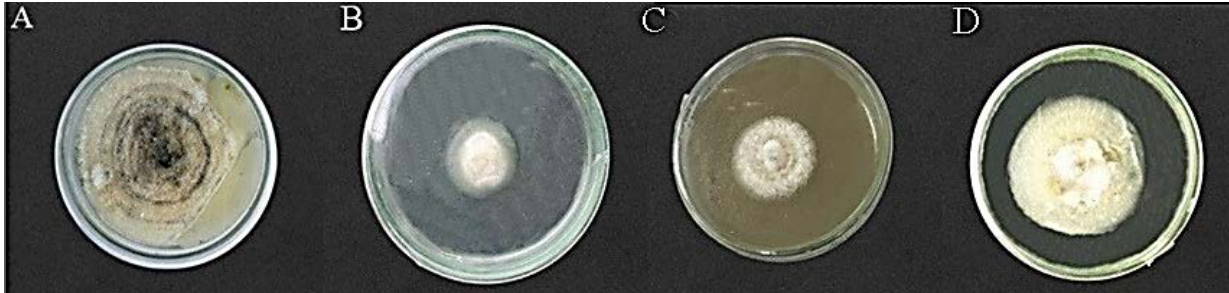
Figure 10. Effect of various concentrations of MB-ZnO on the growth of R. oryzae. ( A ) Control, ( B ) 19 mg/mL concentration, ( C ) 12 mg/mL concentration, ( D ) 6 mg/mL concentration.